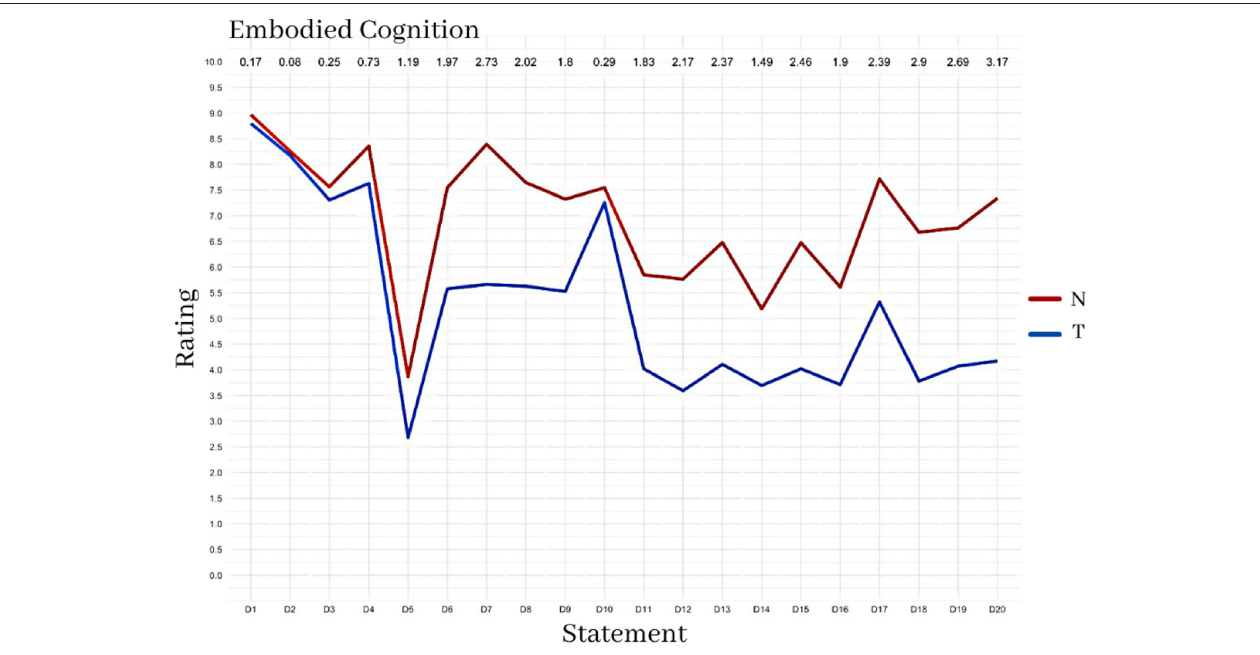
FIGURE 14 | Average response scores to the Embodied Cognition